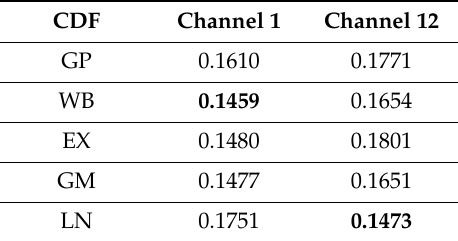
Figure 12. Empirical CDF of channels using OR combining technique. Table 7. KS distance for fitted distribution.